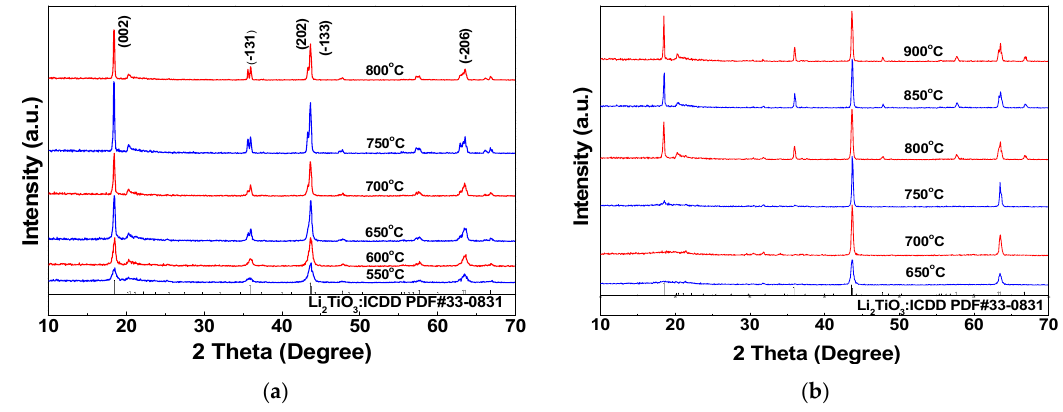
Figure 6. XRD patterns for samples at di ff erent calcination temperatures. ( a ) Li 2 TiO 3 ; ( b ) Li 2 TiO 3 doped with 1%